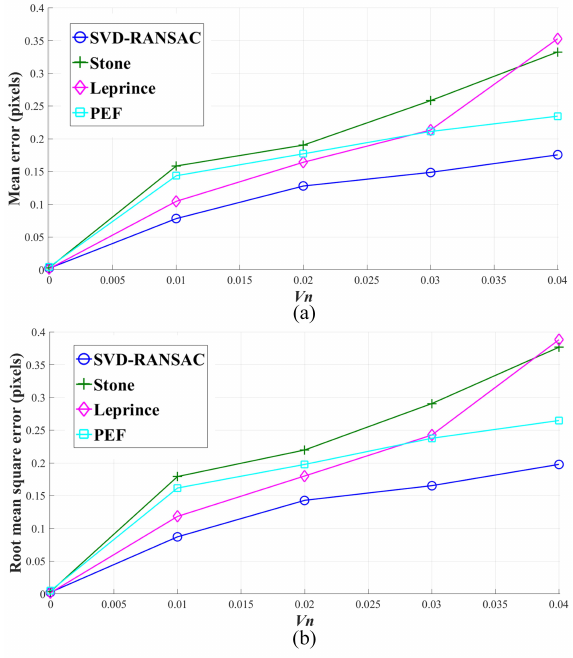
Figure 7. Results of the Noise experiment: (a) MV and (b) RMSE.